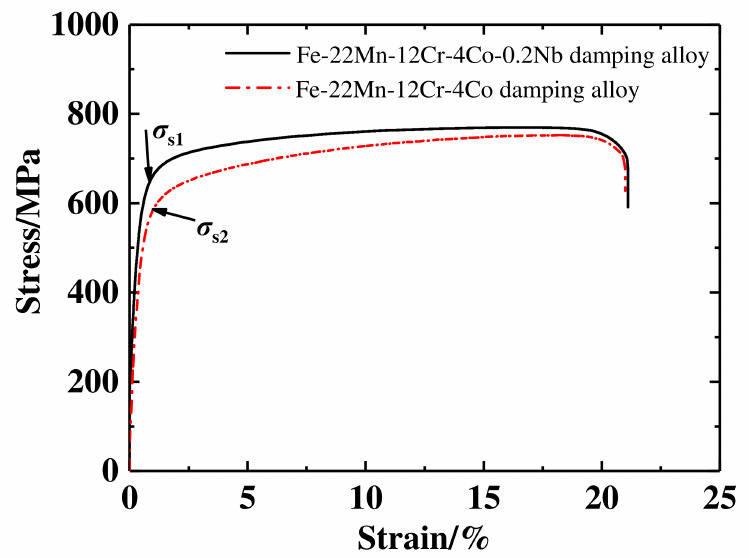
Figure 8. Engineering stress-strain curves of two damping alloy